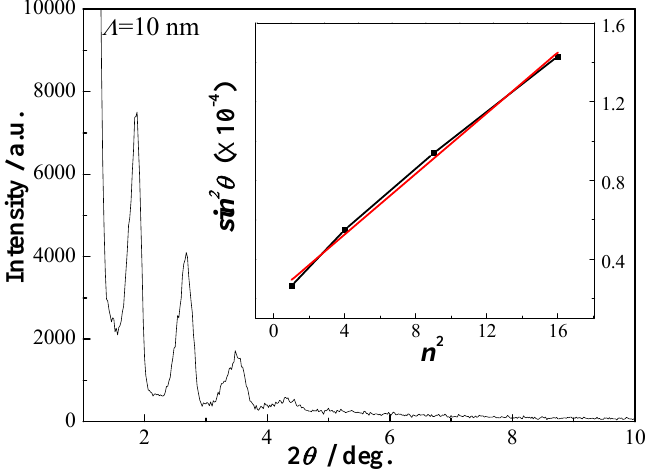
Figure 1. High resolution X-ray reflectivity (XRR) curve of TiAlN/Al ( Λ = 10 nm).